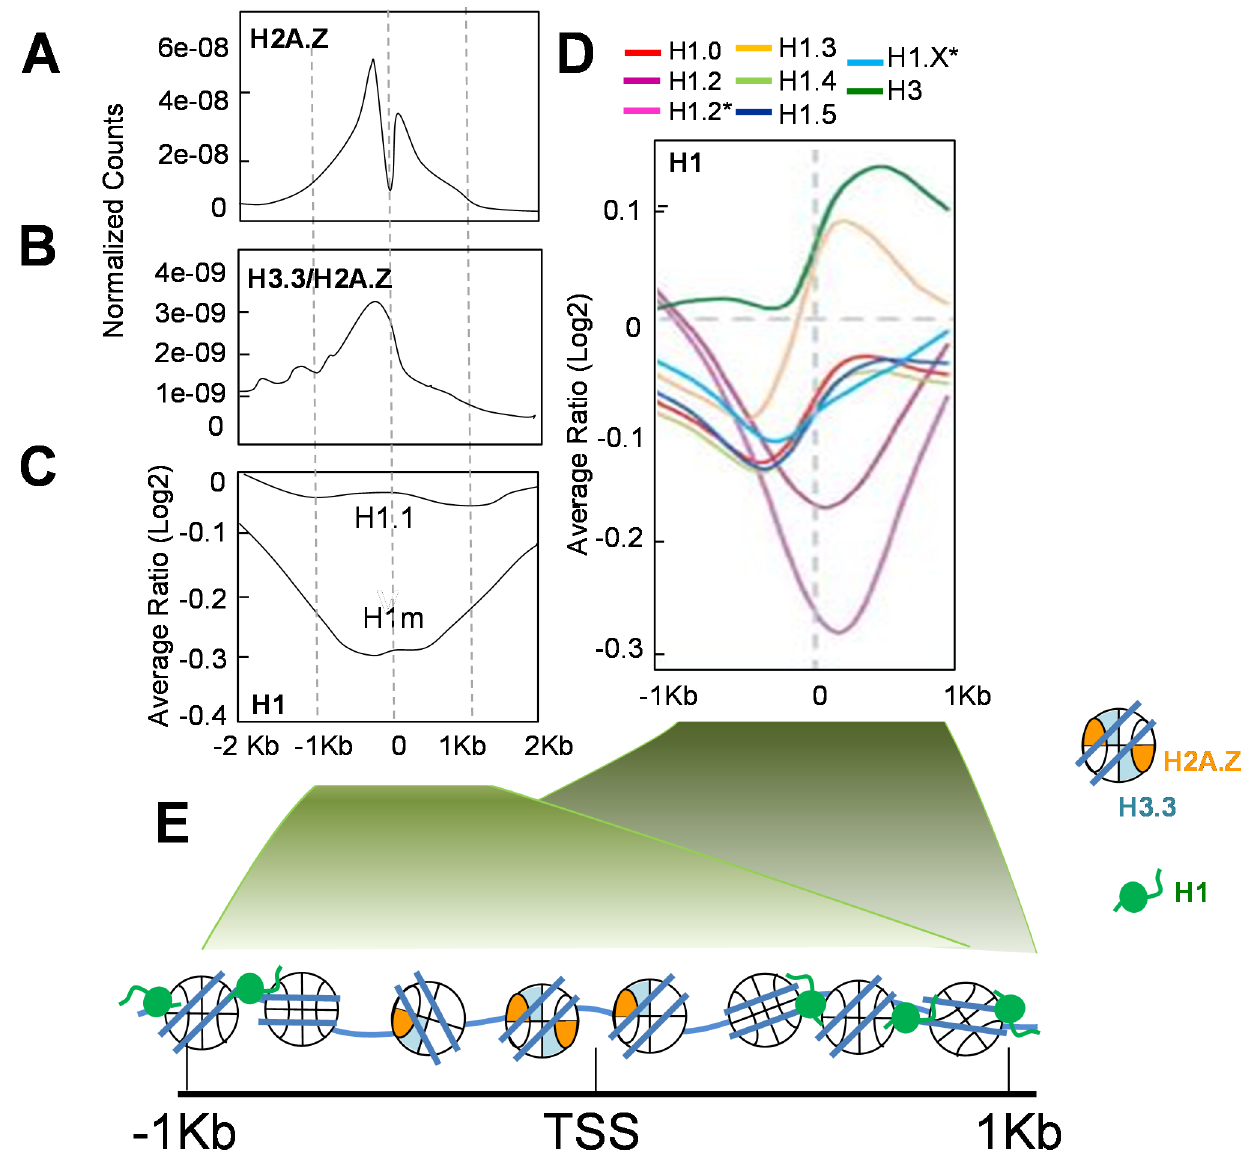
Figure 7. Histone occupancy profiles around TSS. ( A ) Averaged H3.3/H2A.Z nucleosome positioning [70]; ( B ) Profile of histone H2A.Z distribution in high and medium transcriptionally active genes [167]; ( C ) Histone H1 subtypes distribution at TSS for transcribed and non-transcribed genes. H1.1 corresponds to the distribution observed for this subtype as compared to H1m, corresponding to the average for H1.2-H1.3-H1.4-H1.5 [162]; ( D ) Depletion of histone H1-tagged subtypes at promoters. The asterisks indicate analysis conducted using the endogenous histones [163]; ( E ). Schematic representation of histone variants H3.3 and H2A.Z, and histone H1 distribution around gene